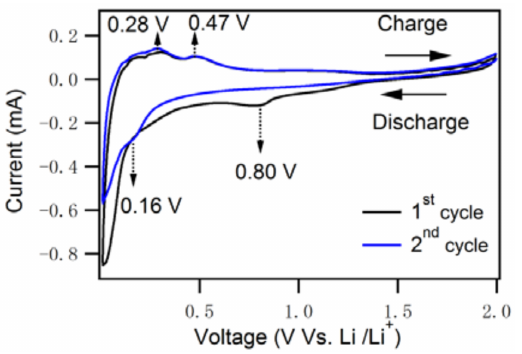
Figure 6. Cyclic voltammograms of 1D–PSiNWs anodes for the first and second cycle at scan rate of 0.1 mV · s − 1 (voltage range: 0.01 V–2.0